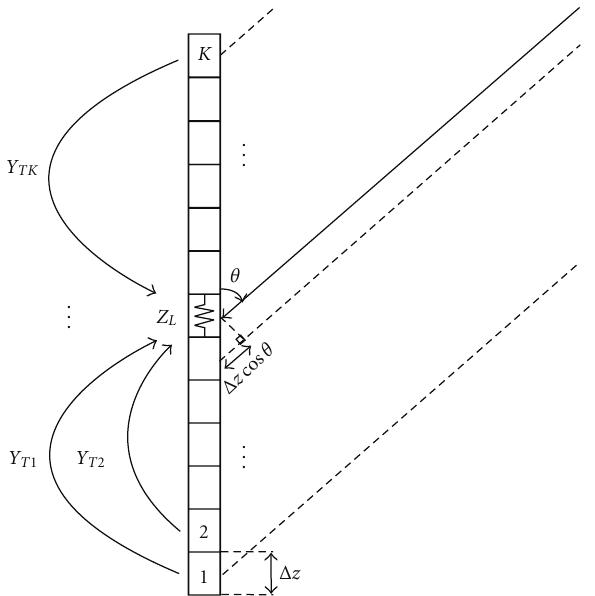
Figure 1: Geometry of the full-wave method for a single vertical dipole, centrally terminated into load impedance Z L , discretized into K segments having an equal length of Δ z , and illuminated by a plane wave arriving from an elevation angle θ . The coe ffi cients Y Tk describe the interactions between the excitation of segment k by the plane wave and the dipole